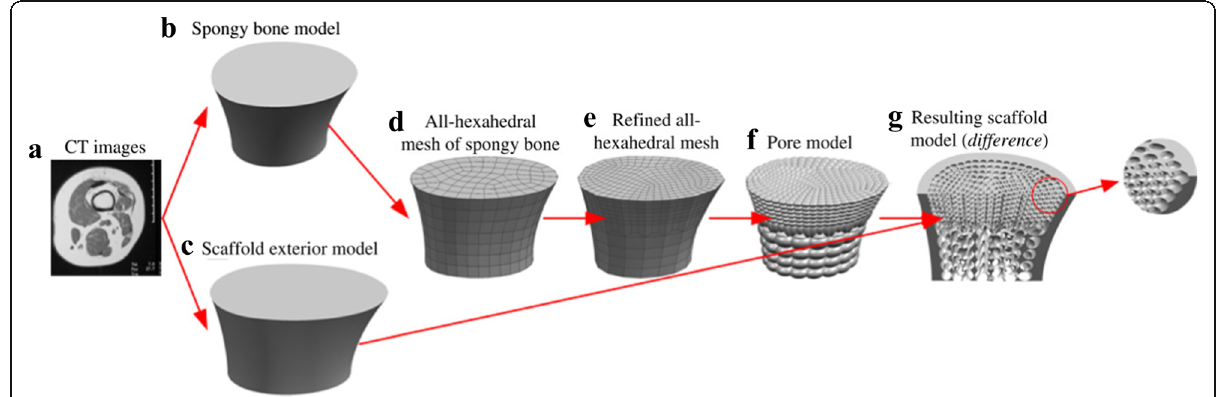
Fig. 15 Scaffold design method based on shape function and sphere pores